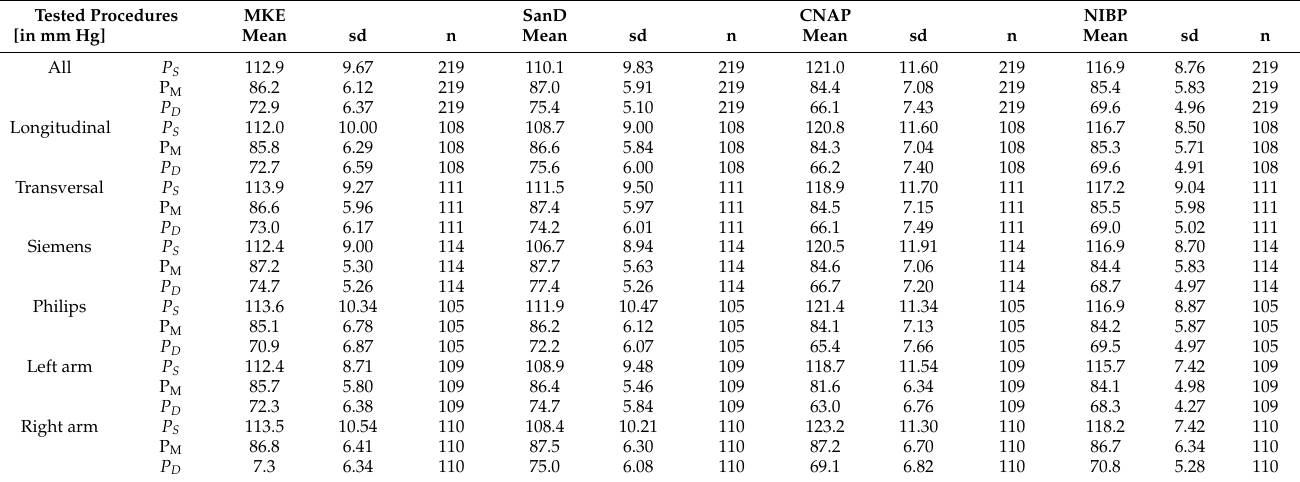
Table 2. Indirectly calculated values for BP according to MKE and SanD, as well as the directly measured values for BP with CNAP and NIBP. The first group contains the values for all measurement times (ALL). In the following groups the values are sorted for the arrangement of the transducer (longitudinally and transversally), for the US devices used (SI = Siemens with 14 MHz transducer and PHI = Philips with 17 MHz transducer), as well as the examinations on the left and right arms.